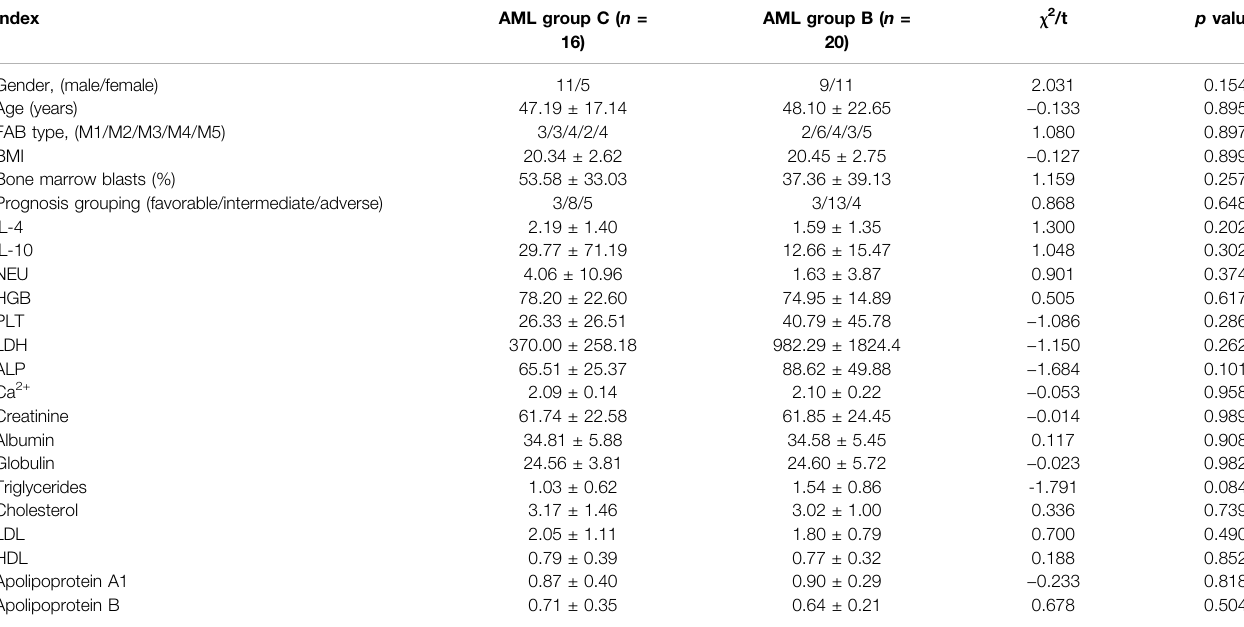
TABLE 2 | Comparison of demographics, prognosis grouping, cytokines and clinical details between the two groups of AML (Means ± SD). Index